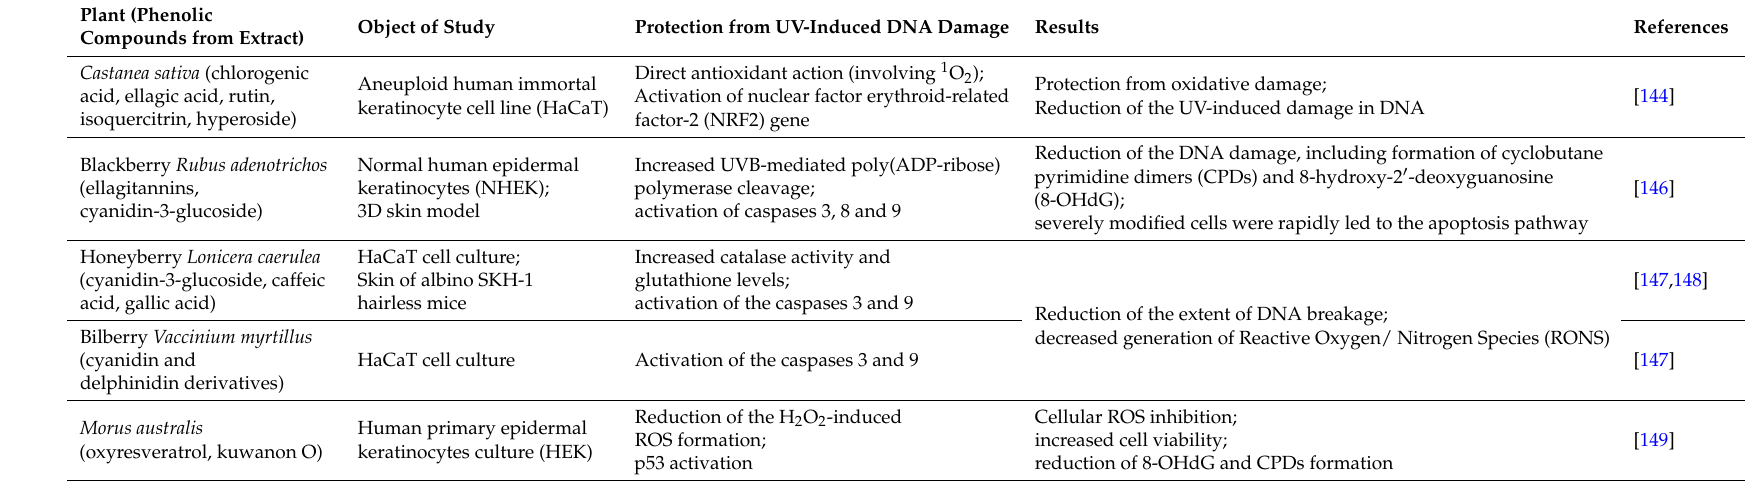
Table 3. The protection activity of the plant extracts from the UV-induced DNA